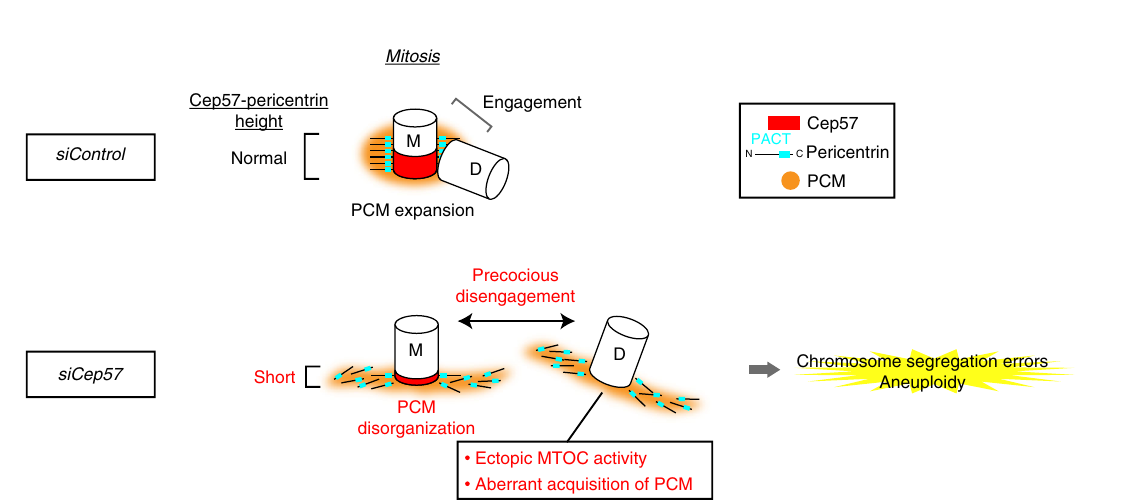
Fig. 5 The binding of PCNT to Cep57 at centrioles is required for the proper localization pattern of PCNT to organize mitotic PCM. a Schematic of PCNT and the Δ PACT mutant or MOPD2 disease-related mutants used for co-IP assays. Coiled-coil domains are shown in gray box and the PACT domain in blue box. The region of PCNT for Cep57-binding is represented in red. The right columns show a summary of the co-IP results and rescue experiments, respectively. b HEK293T cells co-expressing HA-Cep57 and FLAG-PCNT full-length or the indicated mutants were IPed with FLAG antibodies. c The signal intensity of HA-Cep57 bands in b was quanti fi ed. Values are mean ± s.d. from three independent experiments. Tukey ’ s multiple comparisons test was used to obtain p value. * p < 0.05; ** p < 0.01; NS not signi fi cantly different ( p > 0.05). d HeLa cells were treated with siControl or siPCNT, followed by transfection with FLAG empty (control), RNAi-resistant (RNAi-R) PCNT or the indicated mutants. The cells were immunostained with antibodies against FLAG (green), Cep192 (cyan) and CP110 (red). e Histograms represent frequency of mitotic cells with the indicated phenotypes observed in d in each condition. Values are mean percentages ± s.d. from three independent experiments ( n = 50 for each experiment). f Schematic of PCNT and the PCNT-Cep57 chimera mutant used for PCNT knockdown and rescue experiments. g HeLa cells were treated with siControl or siPCNT, followed by transfection with FLAG empty (control), RNAi-resistant PCNT, or the PCNT-Cep57 chimera mutant. The cells were immunostained with antibodies against FLAG (green), Cep192 (cyan), and CP110 (red). h Histograms represent frequency of mitotic cells with the indicated phenotypes observed in g in each condition. Values are mean percentages ± s.d. from three independent experiments ( n = 50 for each experiment). All scale bars, 5 μ m in the low-magni fi ed view, 1 μ m in the inset. Left – right arrows indicate precociously disengaged centrioles. Tukey ’ s multiple comparisons test was used in e and h to obtain p value. * p < 0.05; ** p < 0.01; NS not signi fi cantly different ( p > 0.05)